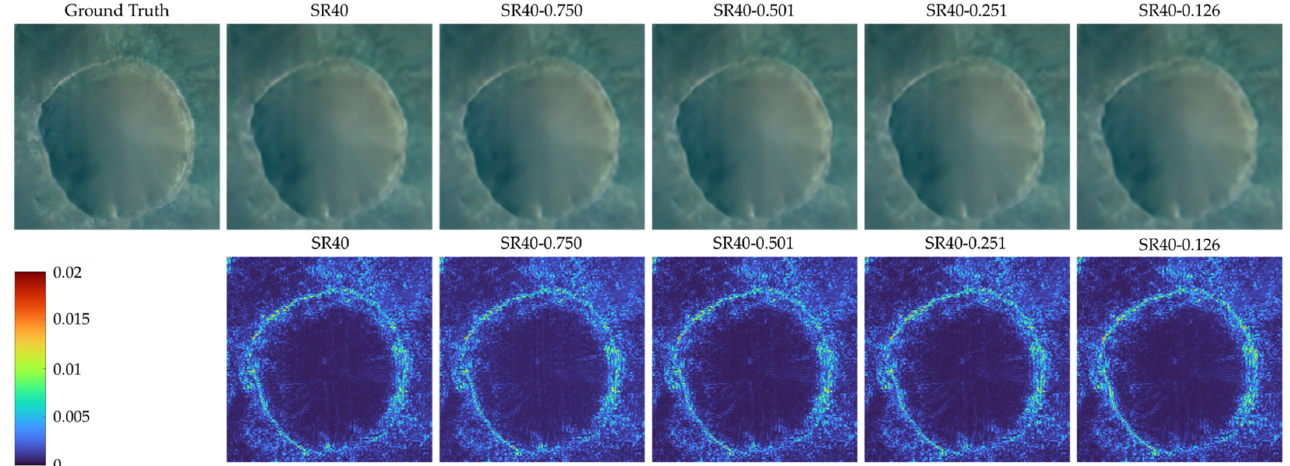
Figure 12. Comparison of the ground truth and the SR reconstruction images and the RMSE of all 235 bands between the ground truth and the other SR reconstruction images.